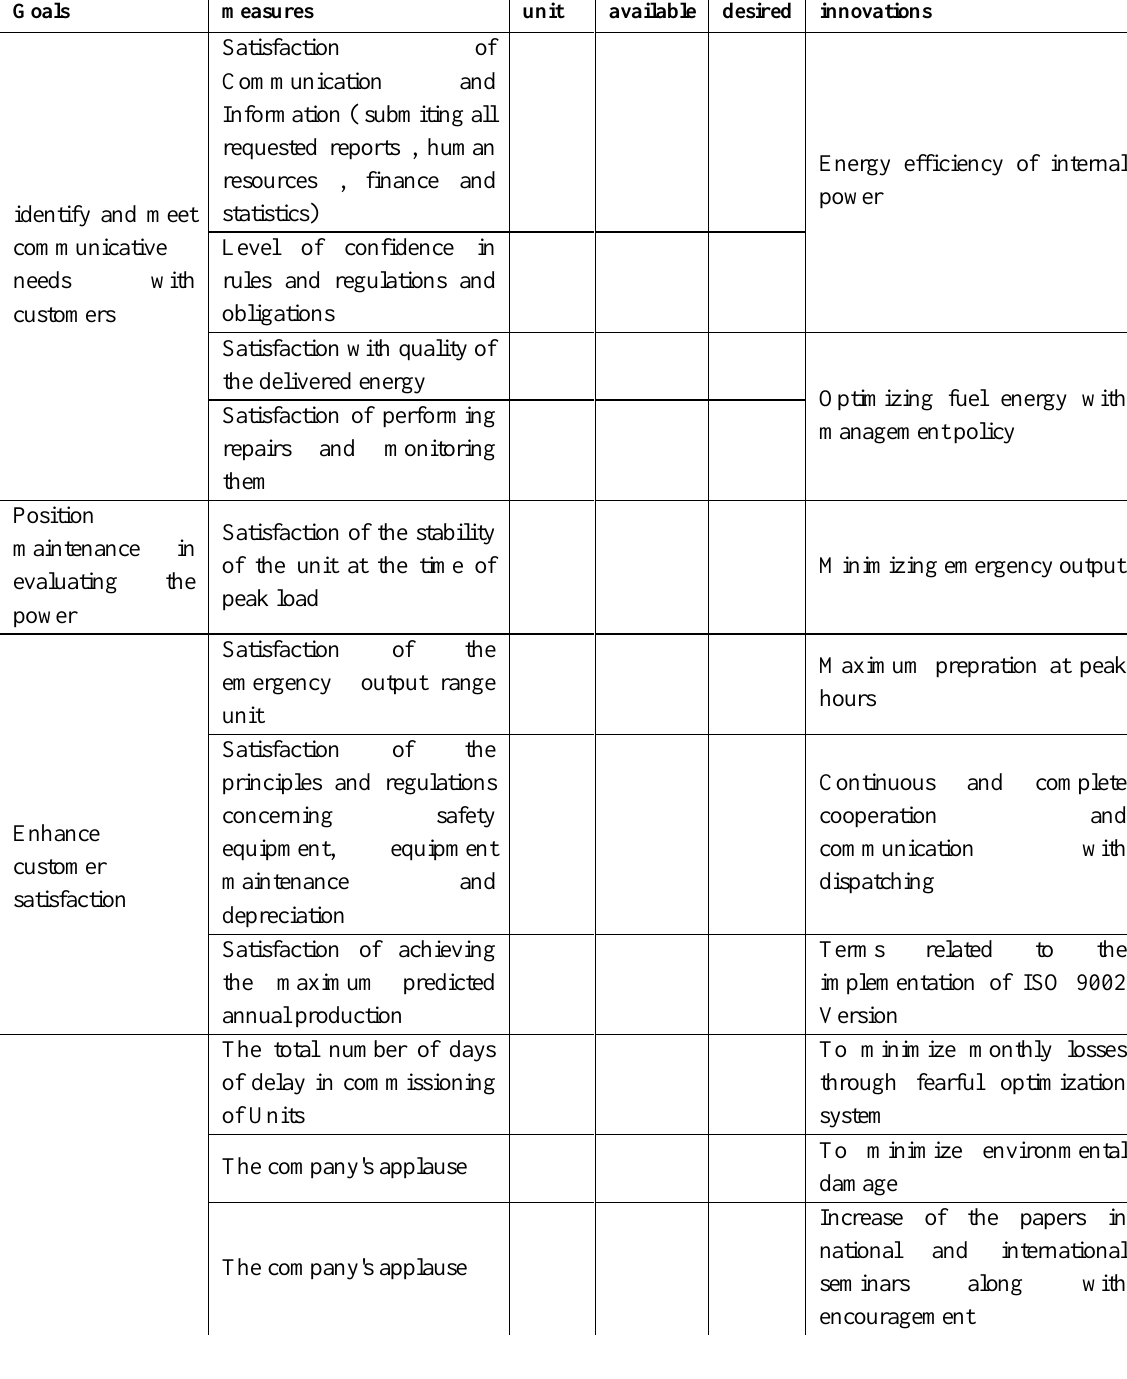
Table 2. Evaluated BSC from a customer's perspective Customer perspective (to fulfill our overview while improving customer satisfaction, position of the company in power evaluation will be maintained)